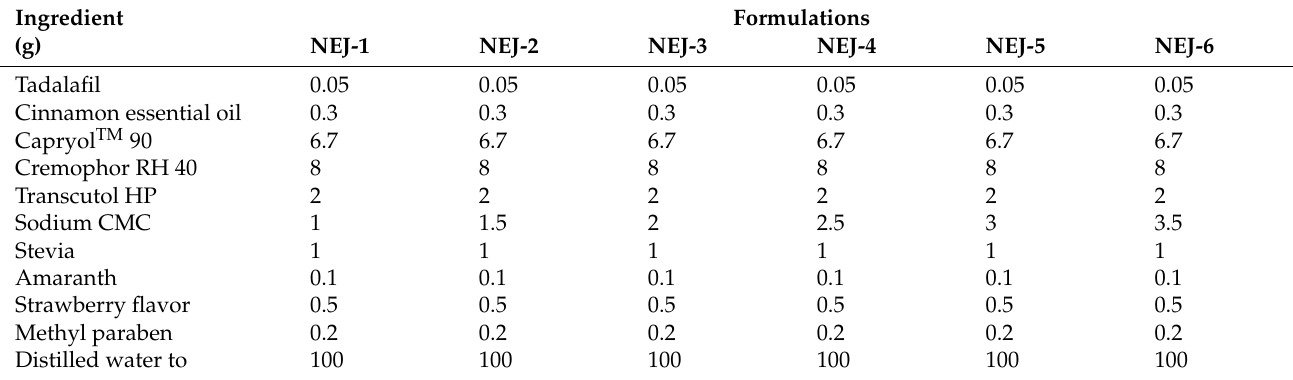
Table 3. Tadalafil jelly